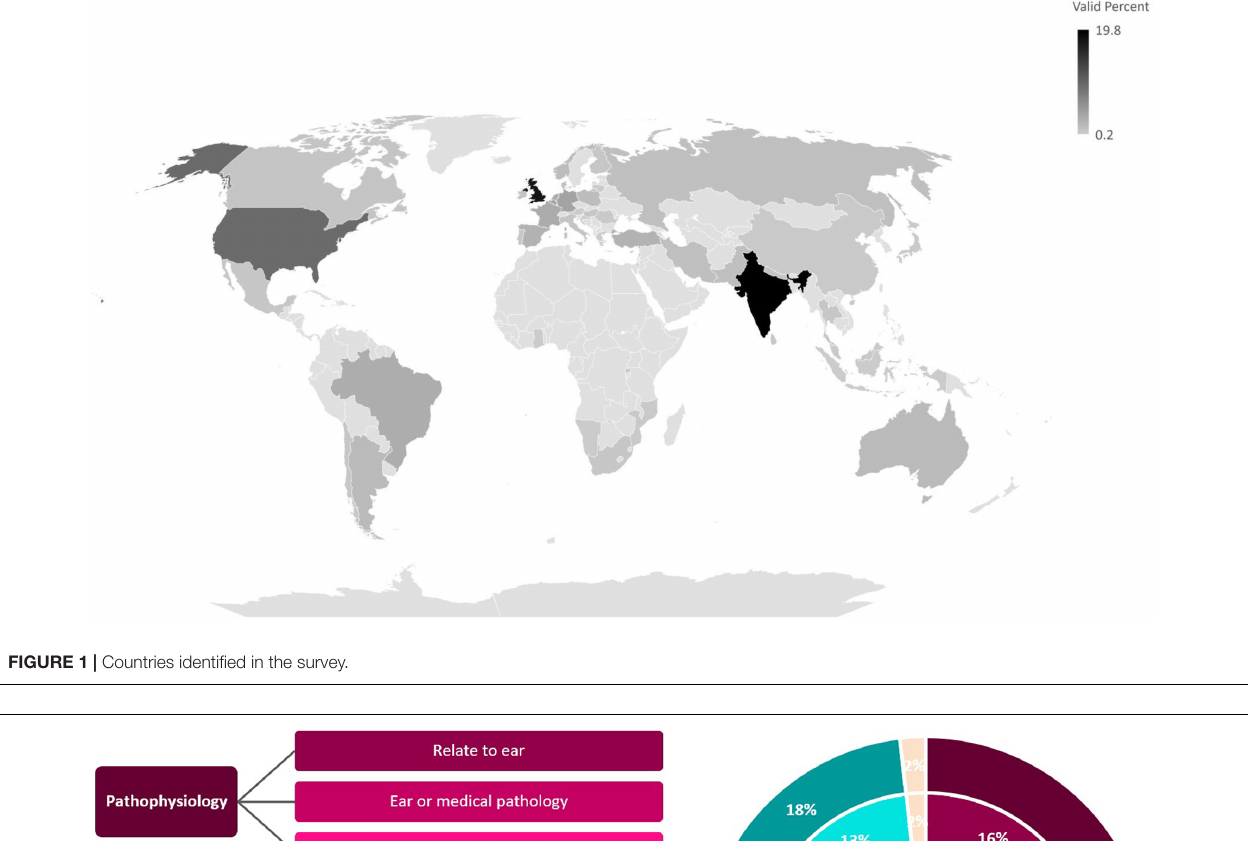
FIGURE 1 | Countries identified in the survey.